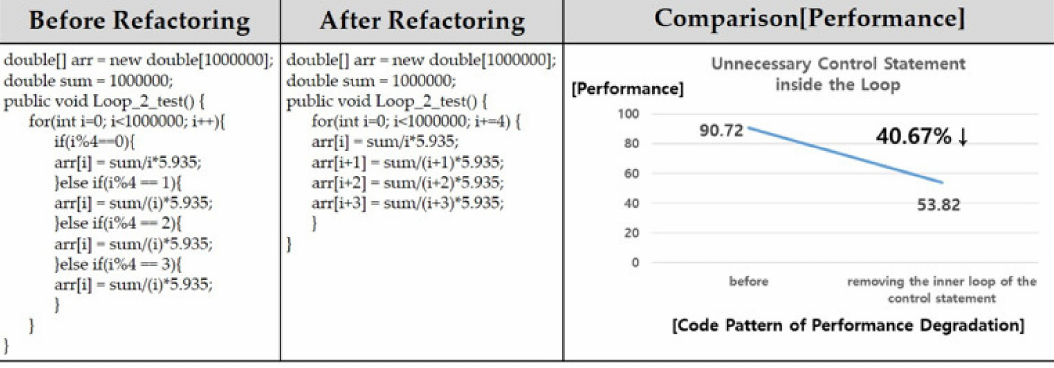
Figure 15. Before and after improving unnecessary control statement inside the